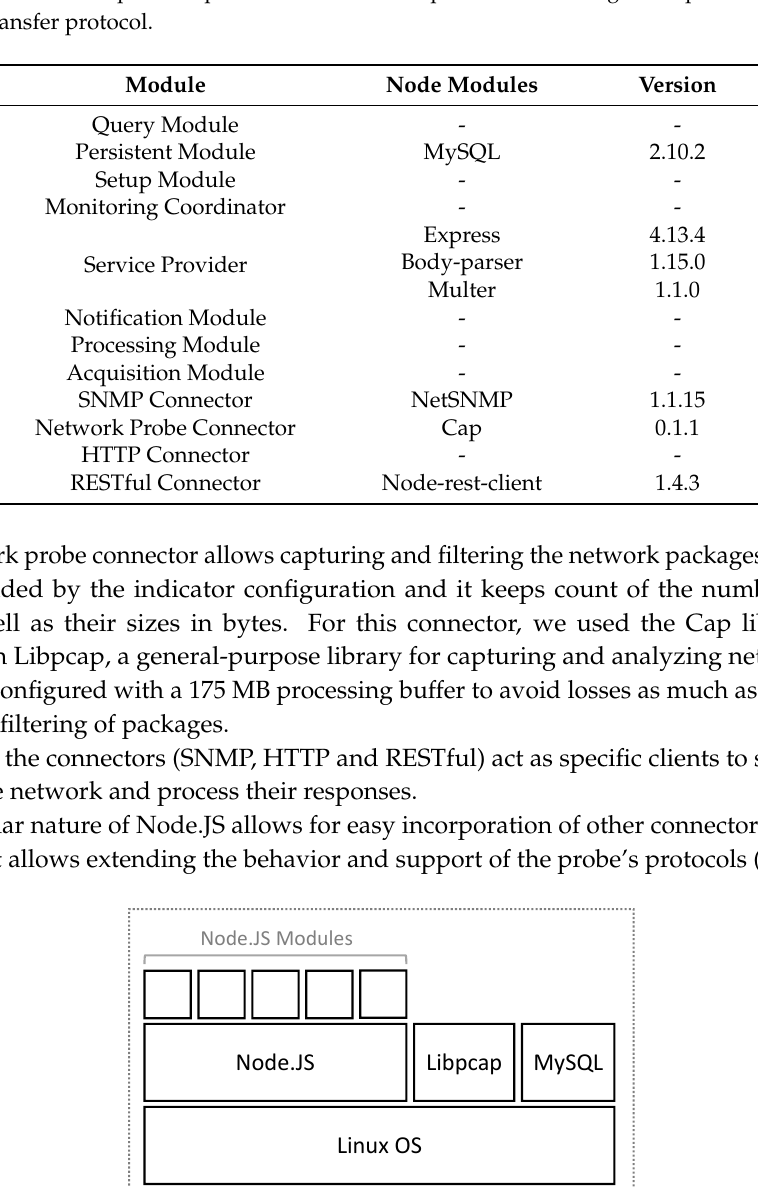
Table 3. Characteristics of each prototype. SD: secure digital; and USB: universal serial bus. Feature